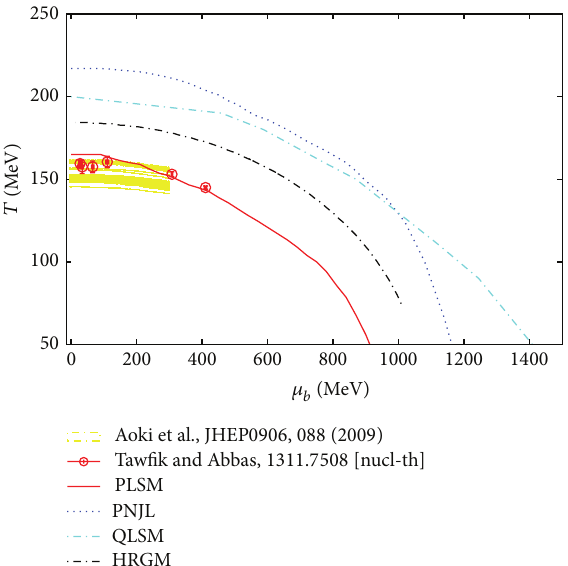
Figure 3: The PLSM 𝑇 - 𝜇 chiral phase-diagram (lines with points), with which the freeze-out parameters deduced from lattice the QCD calculations [84–86] (band) and that from different thermal models [87–89] (symbols) are